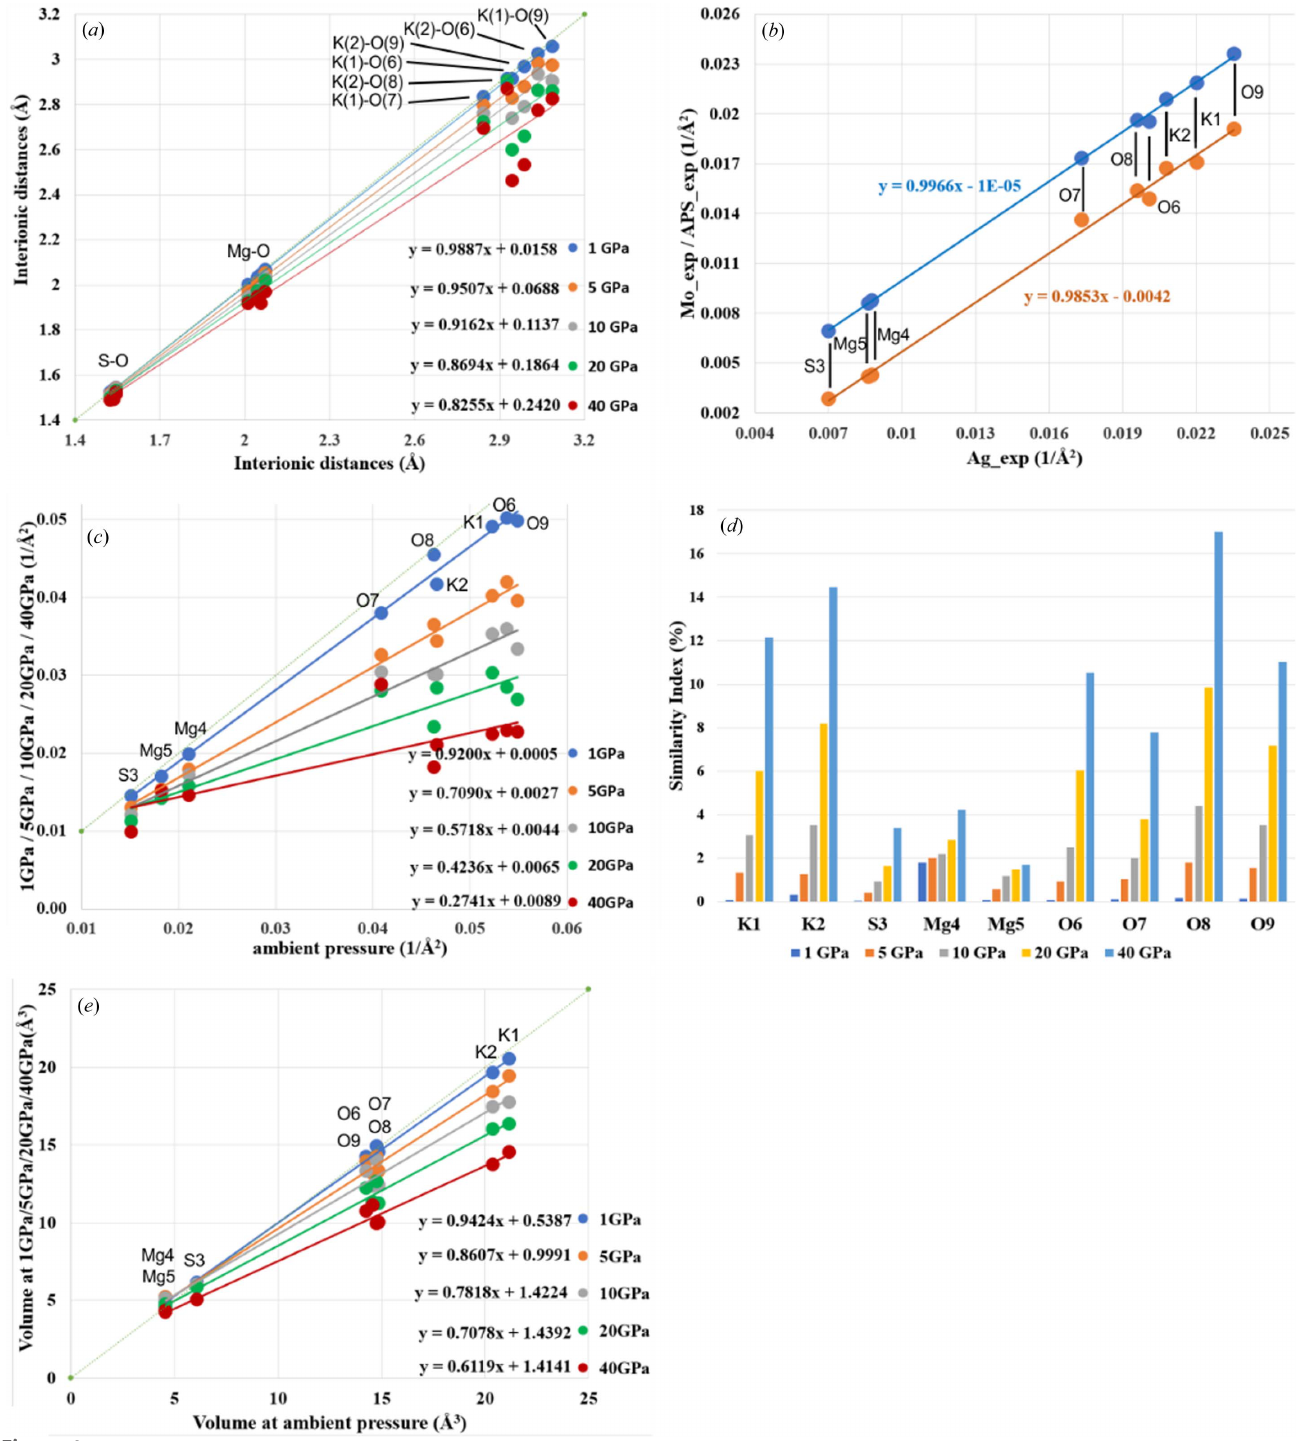
Figure 4 ( a ) Interionic distances as a function of pressure (data correspond with Table S7). ( b ) Average eigenvalues for specific ADPs obtained on the basis of synchrotron measurements and in-house measurements. Blue dots – relation between Ag_exp and Mo_exp, orange dots – relation between Ag_exp and APS_exp. ( c ) Average eigenvalues for specific ADPs obtained on the basis of theoretical calculations. ( d ) Similarity index calculated for ADPs obtained on the basis of theoretical dynamic structure factors. ( e ) Volumes of integrated atomic basins under pressure versus integrated ambient atomic basins – all from theoretical